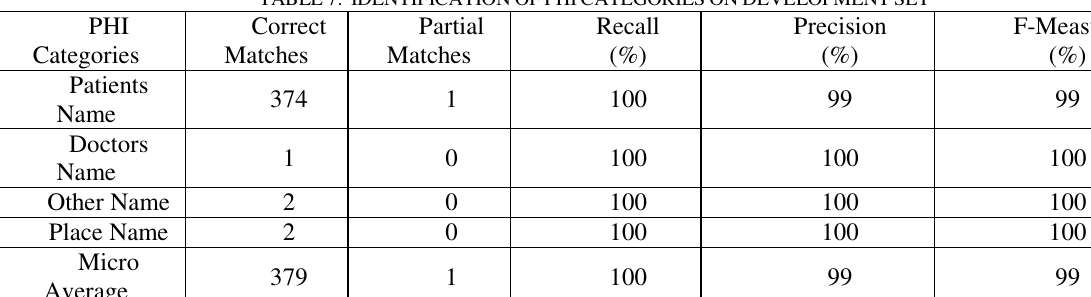
TABLE 7: IDENTIFICATION OF PHI CATEGORIES ON DEVELOPMENT SET